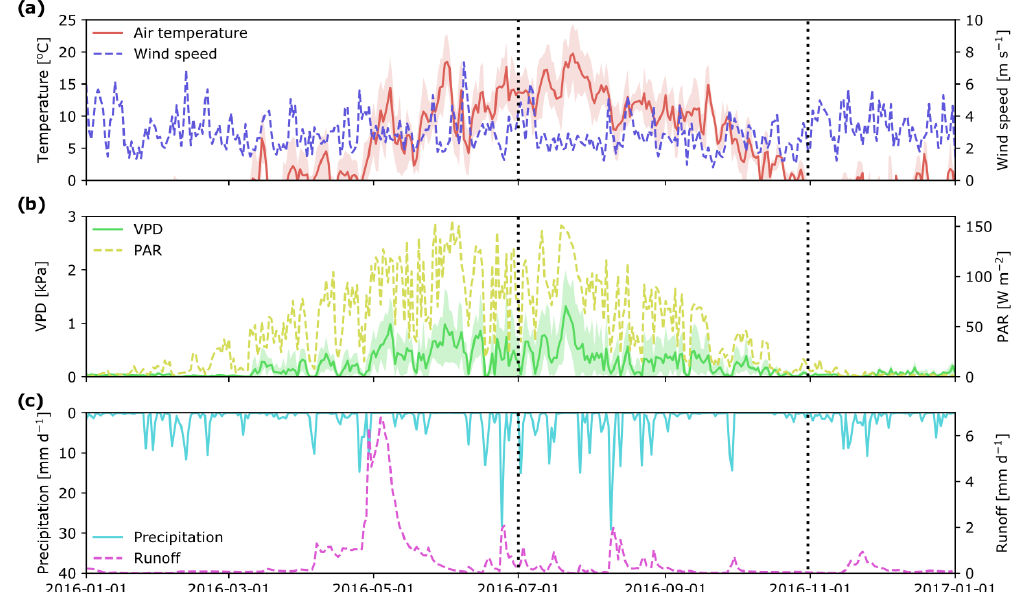
Figure 2. Mean daily hydro-meteorological variables at the Krycklan C2 subcatchment during 2016: air temperature and wind speed (a) ; vapor pressure deficit, VPD, and photosynthetically active radiation, PAR (b) ; precipitation and stream runoff (c) . Beginning and end of the study period are marked with vertical dotted lines. Shaded areas for air temperature and VPD show minimum and maximum values during a